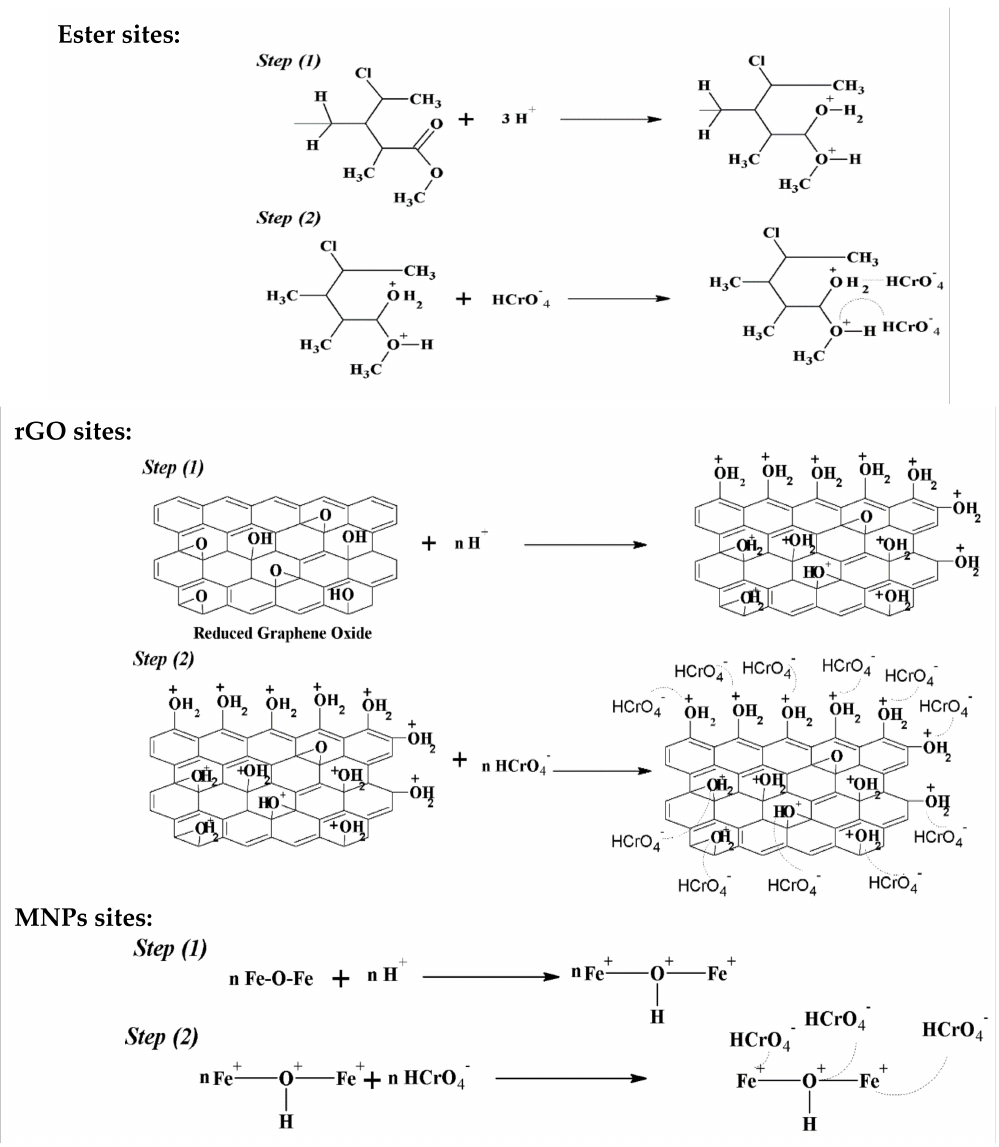
Scheme 4. Structure of adsorption